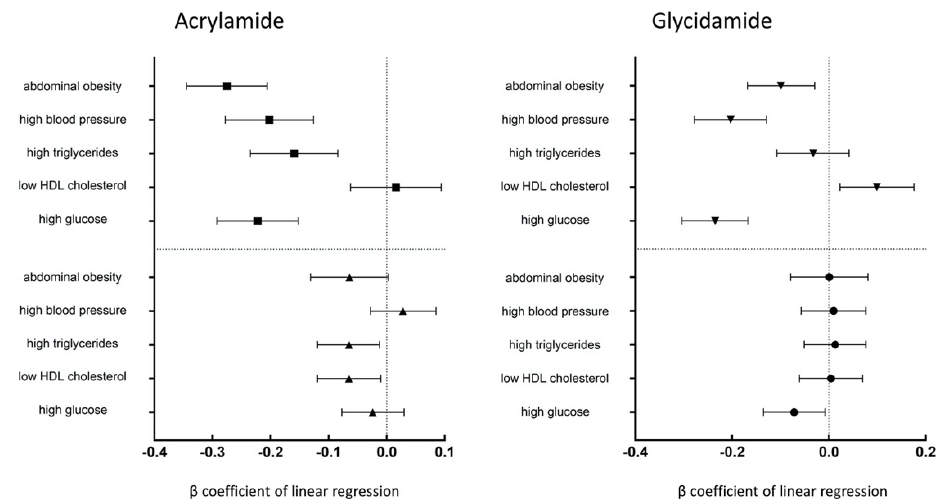
Figure 1. Correlations between concentrations of HbAA and HbGA and markers of metabolic syndrome. The prevalence of high triglycerides, low HDL cholesterol in the adjusted model was inversely associated with the concentrations of HbAA ( p < 0.05). The prevalence of high FPG in the adjusted model was inversely associated with the concentrations of HbGA ( p < 0.05). Table 4. Association of concentrations of HbAA and HbGA and prevalence of metabolic syndrome with quartile analysis. HbAA HbGA OR (95% CI) p Value OR (95% CI) p Value Model 1